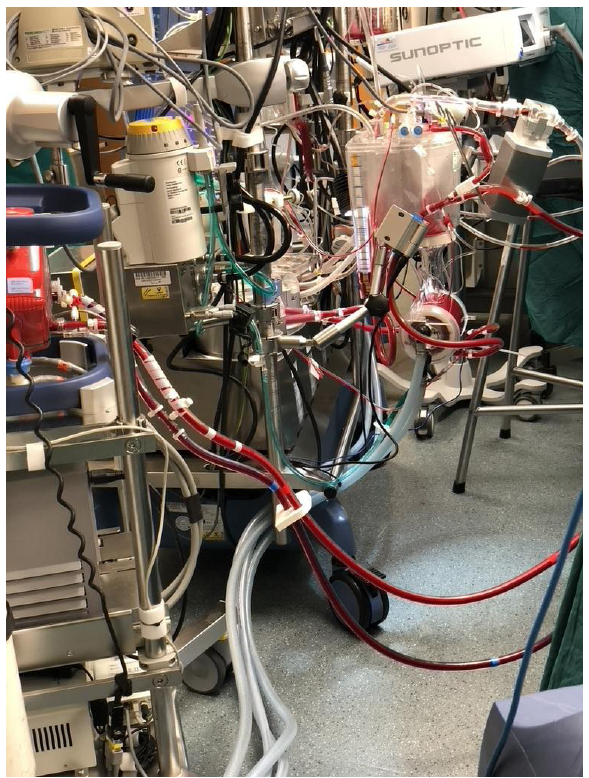
Fig. 1 - Venoarterial extracorporeal membrane oxygenation